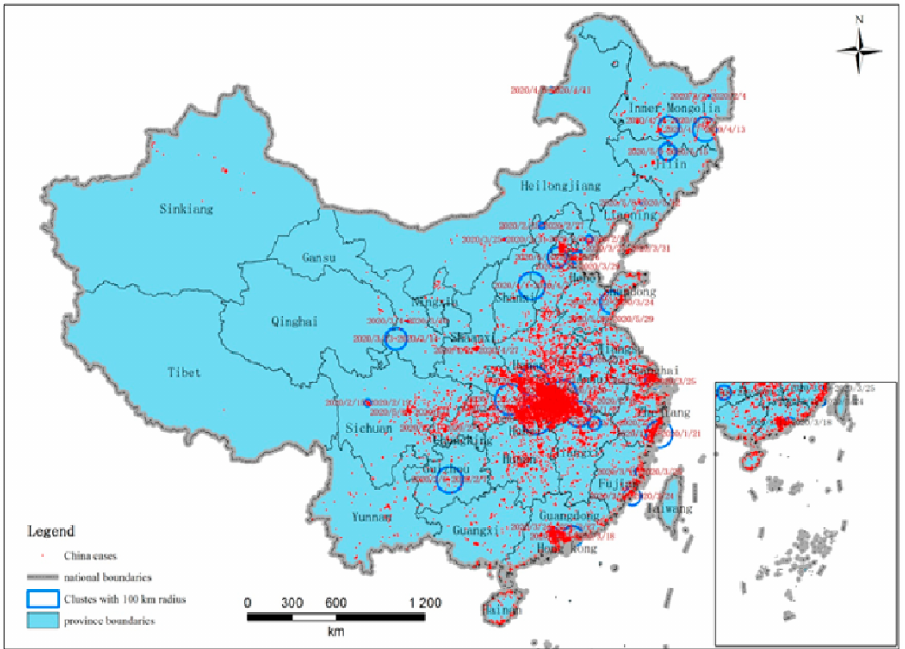
Figure 3. Space-time clusters of COVID-19 at the family-level with a maximum spatial scanning window size of 100 km in mainland China from 2 December 2019 to 20 June 2020.